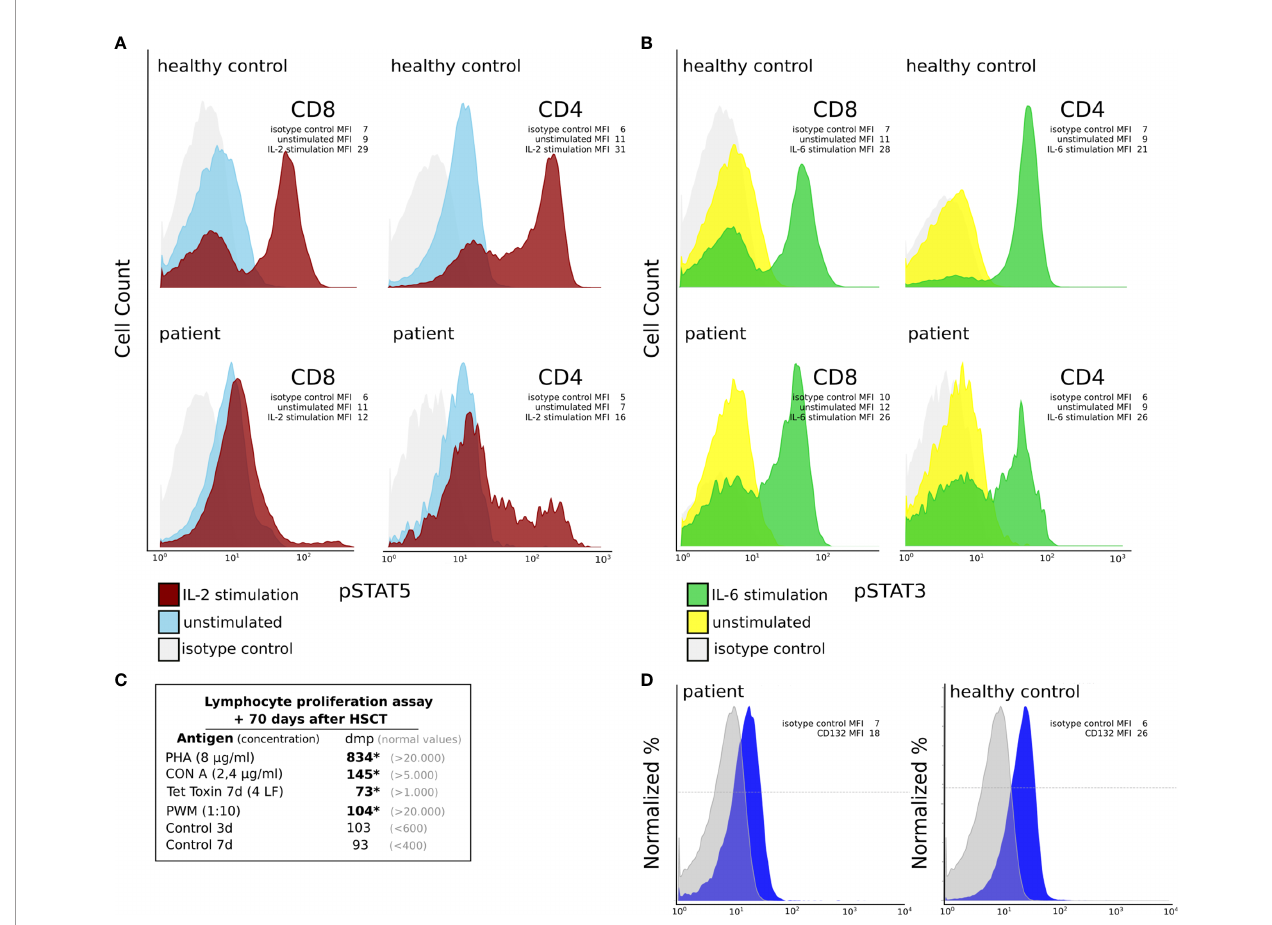
FIGURE 3 | Functional characterization of CD4 + and CD8 + T cells at day +70 post HSCT. (A, B) IL-2RG function analysis in CD4 + and CD8 + T cells of the patient using fl ow cytometry. (A) We could fi nd decreased pSTAT5 expression following IL-2 stimulation (red curve), which is known to be IL2RG dependent, in CD8+ T cells of the patient compared to those of a healthy control. In the patient pSTAT5 expression could be detected in a small subset of CD4 + T cells only. The mean fl uorescent intensities (MFI) are shown for the isotype control, IL-2 stimulated and unstimulated cells (B) IL2RG independent pSTAT3 expression following IL-6 stimulation (green curve) in CD8+ and CD4 + T cells was comparable between patient and healthy control. Unstimulated cell ’ s expression histograms are shown in blue (for pSTAT5) and yellow (for pSTAT3). The grey curves depict an isotype control. The mean fl uorescent intensities (MFI) are shown for the isotype control, IL-6 stimulated and unstimulated cells. (C) Lymphocyte proliferation assays +70 days post-HSCT. We can detect reduced (*) lymphocyte proliferation following stimulation with PHA, CON A, Tetanus toxin and PWM (dmp = disintegrations per minute of 3H-thymidine incorporation). (D) IL2RG (CD132) expression on T cells using fl ow cytometry. The mean fl uorescent intensities (MFI) are shown for the isotype control and